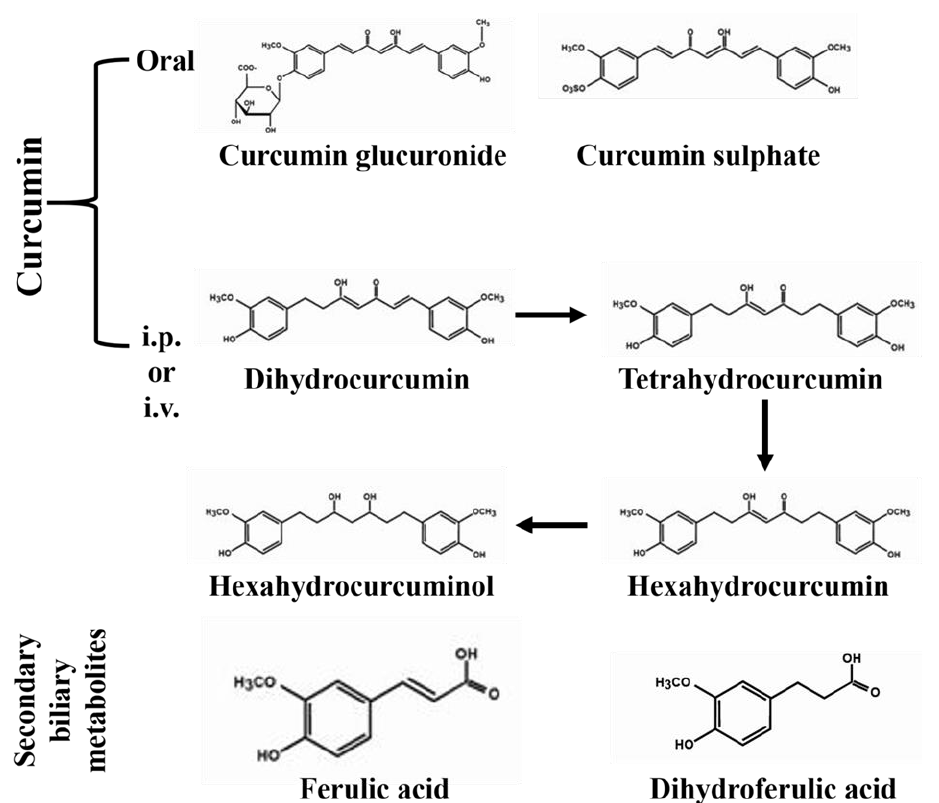
Figure 2. Structures of curcumin metabolites following oral or intraperitoneal (i.p.) or intravenous (i.v.) administration.